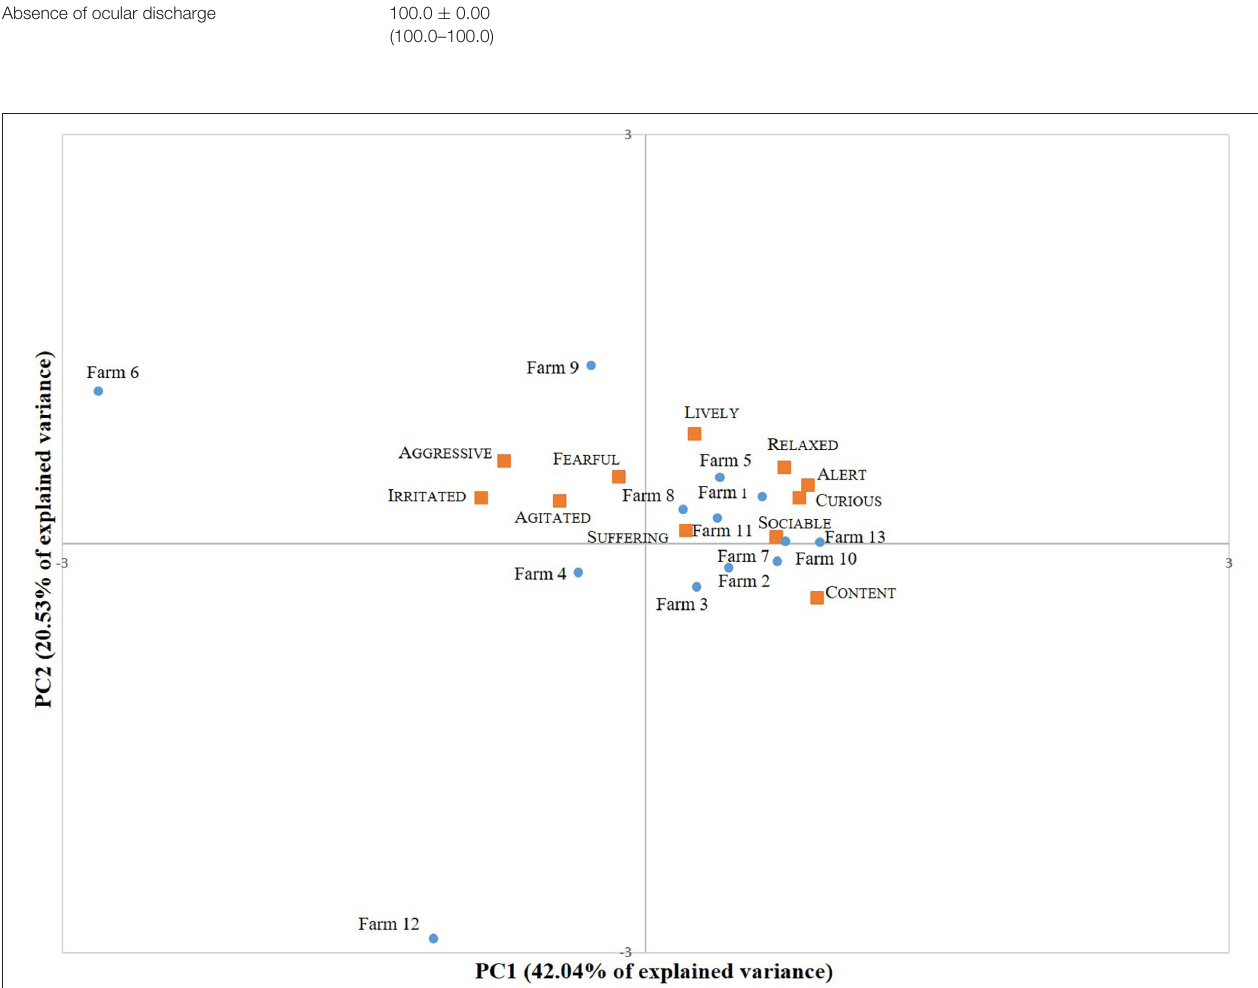
FIGURE 2 | Biplot showing the loadings of the descriptors ( ) and the farm scores ( ) on PC1 and PC2.